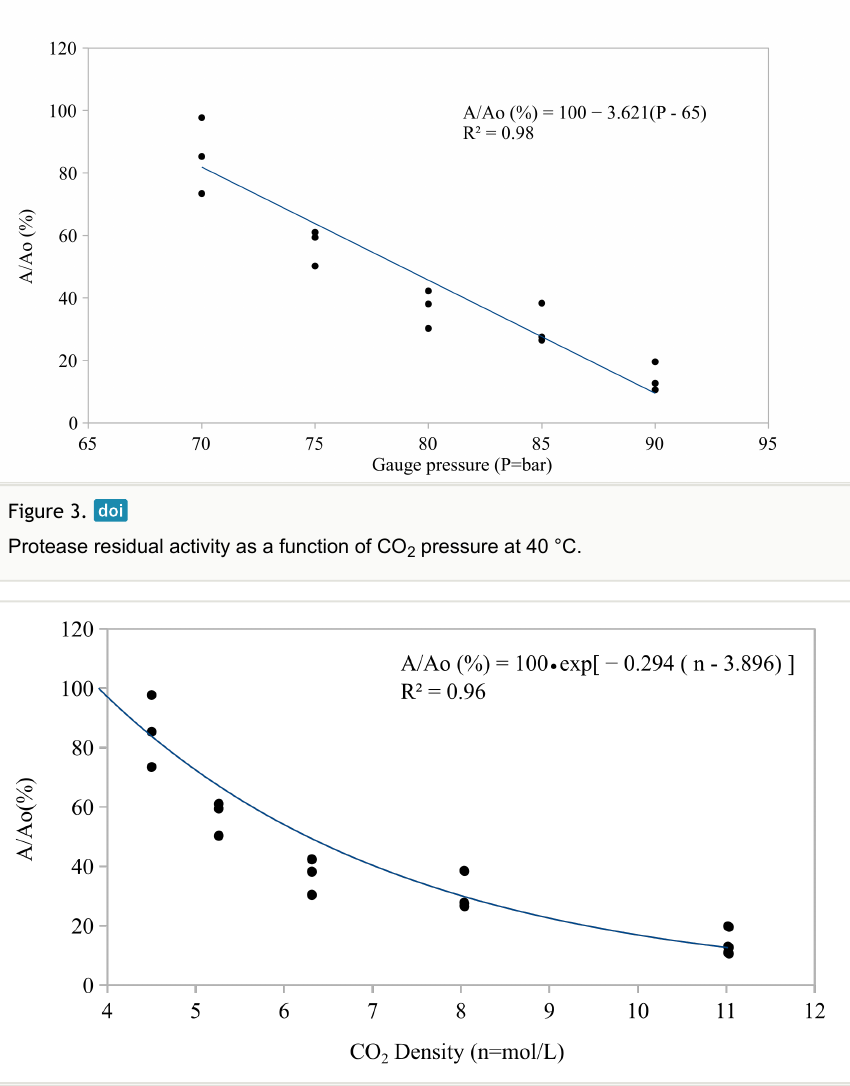
Figure 4. Protease residual activity as a function of CO density at 40 °C.